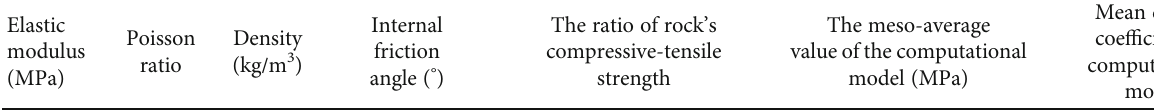
Table 6: Parameters related to the numerical calculation model.